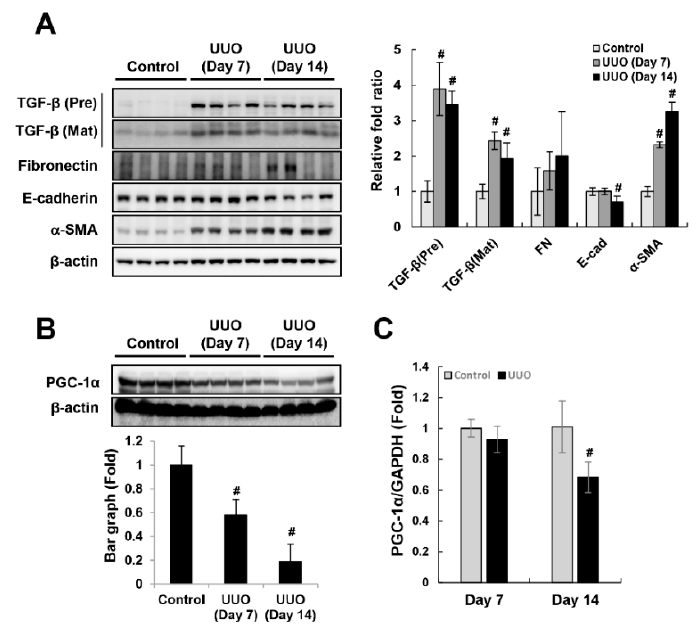
Figure 1. Downregulation of PGC-1 α in the unilateral ureteral obstruction (UUO)-induced fibrotic kidney. To assess the fibrotic progression in the left kidney during ureter obstruction, we analyzed the expression of fibrotic marker proteins (premature and mature forms of TGF- β , fibronectin, and α -SMA) and an epithelial marker protein (E-cadherin) ( A ). To assess the involvement of PGC-1 α in fibrotic progression, we analyzed the protein ( B ) and mRNA ( C ) levels of PGC-1 α in whole-kidney homogenates. Bar graphs of protein levels show mean PGC-1 α / β -actin expression, as measured by densitometry, and bar graphs of mRNA levels show mean PGC-1 α /GAPDH expression. # p < 0.05, day 7 and day 14 UUO kidney vs. control kidney.